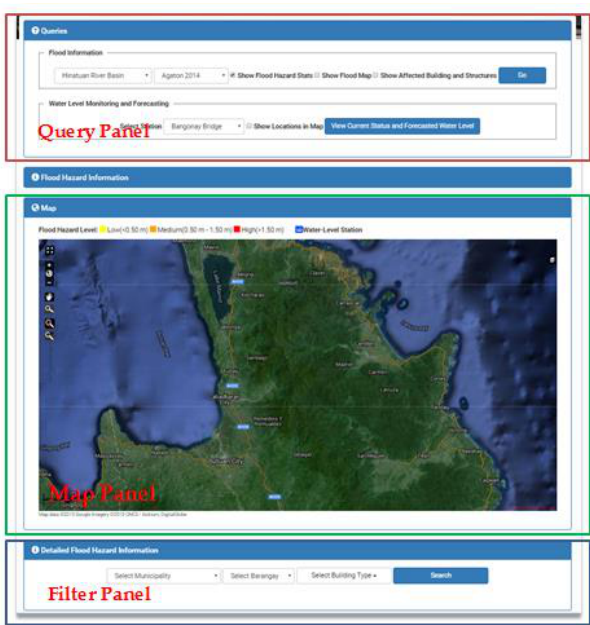
Figure 4. Major panels of the Flood EViDENs GUI.